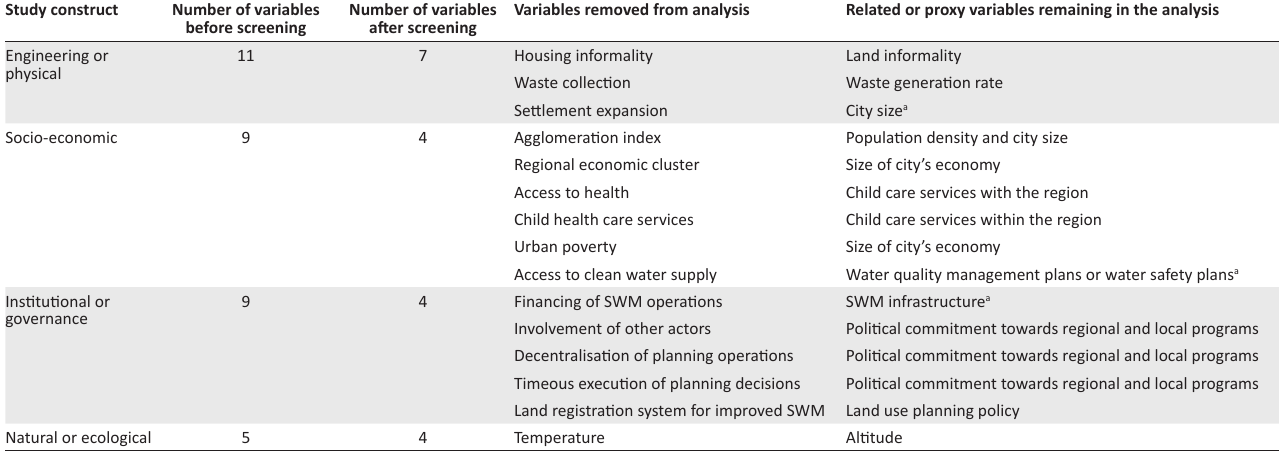
TABLE 2: Removed variables that are constituted in the analysis. Study construct